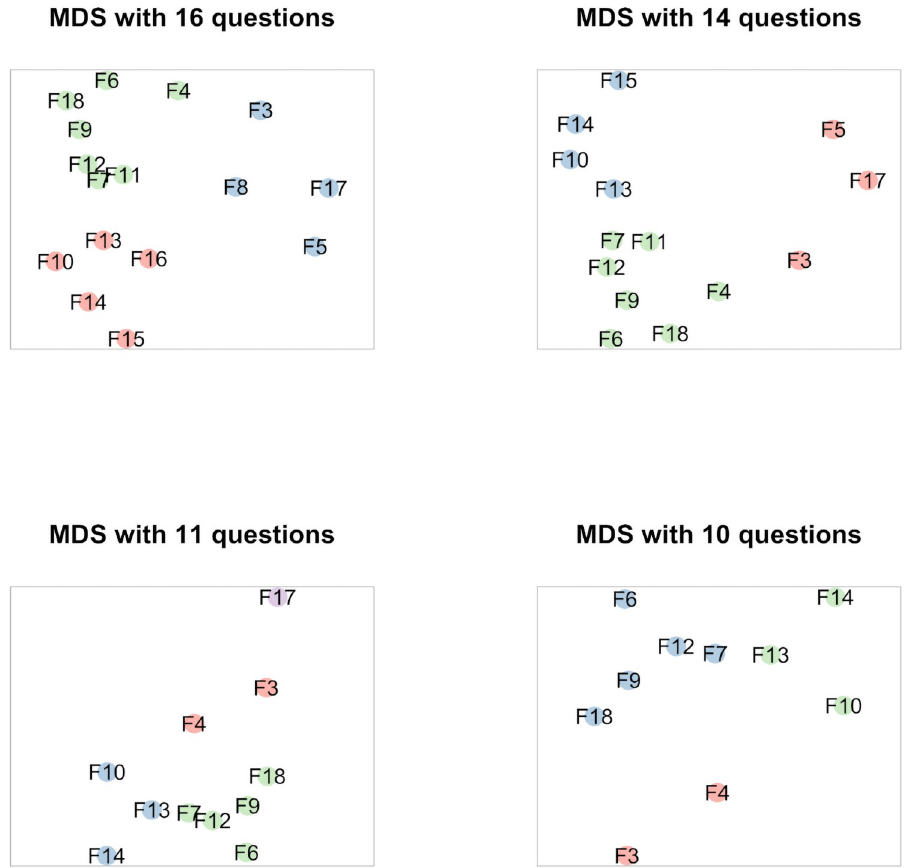
Fig 2. Configuration plots for the MDS solutions for all 16 questions, and then subsets of interest. Proximity of questions in the plots represents the correlation between responses, so that questions that are close received highly- similar responses. Colours correspond to groups of questions chosen through an application of k-means